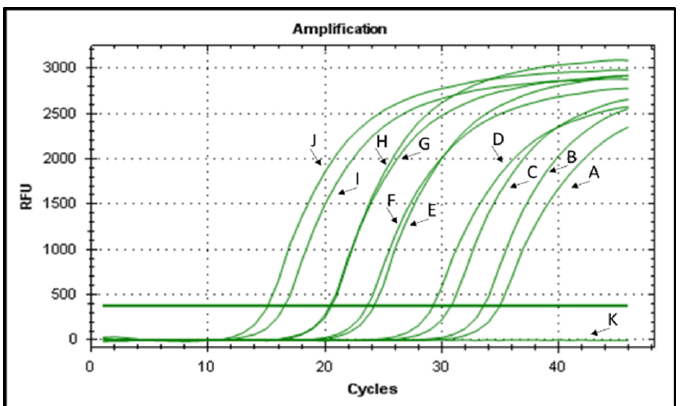
Figure 3. Viable-quantitative PCR DNA amplification curves obtained from (A) treated- Erwinia am- ylovora with KL29 at 50 µM; (B) IL14 at 50 µM; (C) KL29 at 250 µM; (D) IL14 at 250 µM; (E) FG22 at 50 µM; (F) GF19 at 50 µM; (G) FG22 at 250; (H) GF19 at 250 µM; (I) untreated Erwinia amylovora ; (J) genomic DNA of Erwinia amylovora used as positive control; and (K) genomic DNA of Xanthomonas campestris used as a negative control. The v-PCR assay was performed in 4 replicates for each concentration. The result of a replication is displayed.